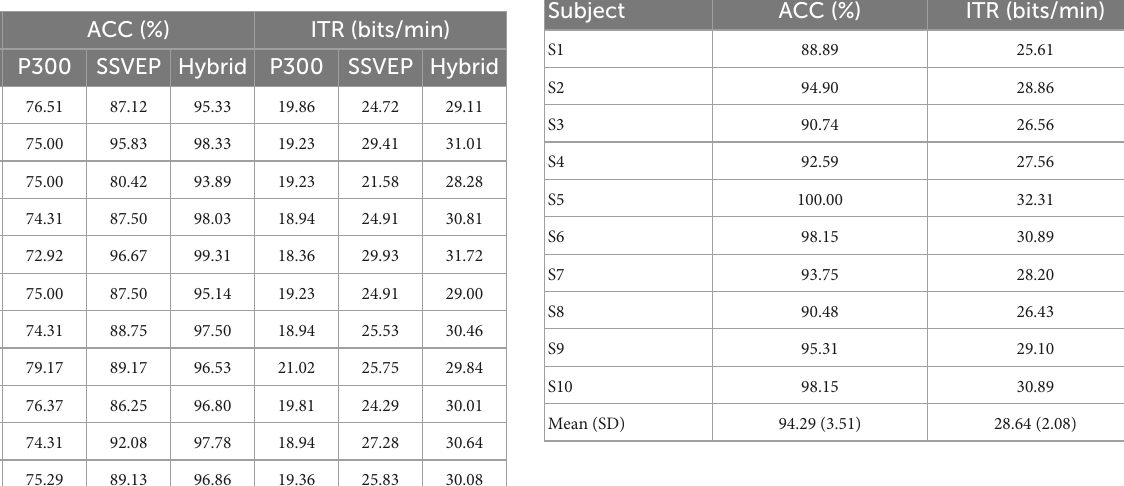
TABLE 2 Performance of the hybrid speller in the online